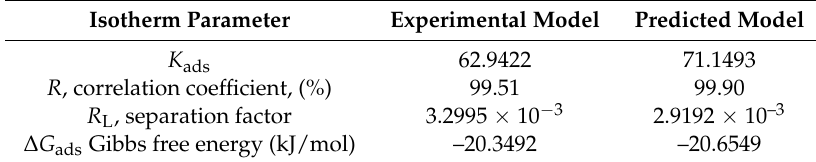
Figure 5. Plots of Langmuir adsorption isotherm fittings of experimental and correlation predicted performance of P. muellerianus leaf-extract on steel-reinforcement corrosion in the chloride contaminated environment. Table 3. Parameters from Langmuir adsorption isotherm fitting of corrosion